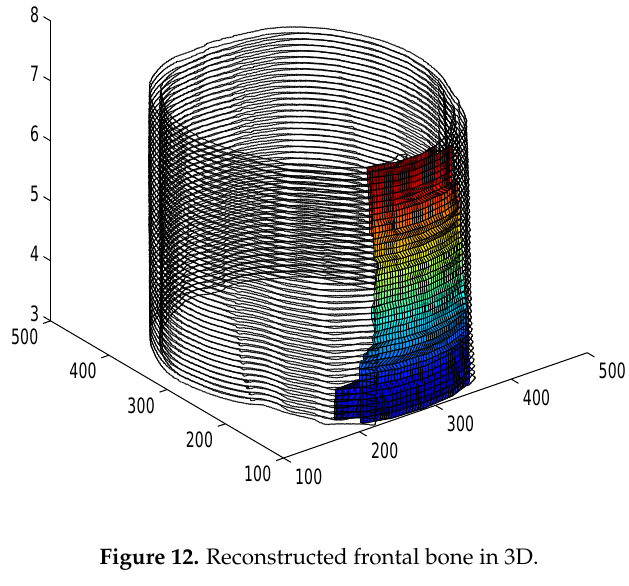
Figure 12. Reconstructed frontal bone in 3D.